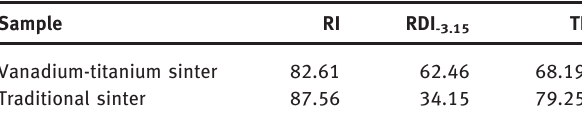
Table 2: Metallurgical properties of the sinters